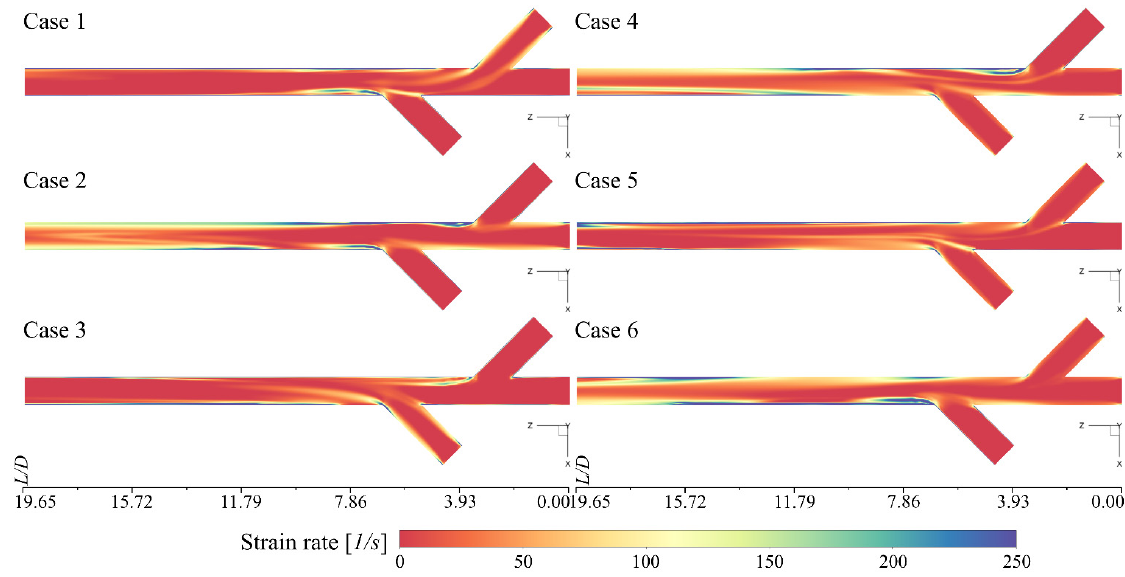
Figure 4. Strain rate contours of the different injection scenarios.